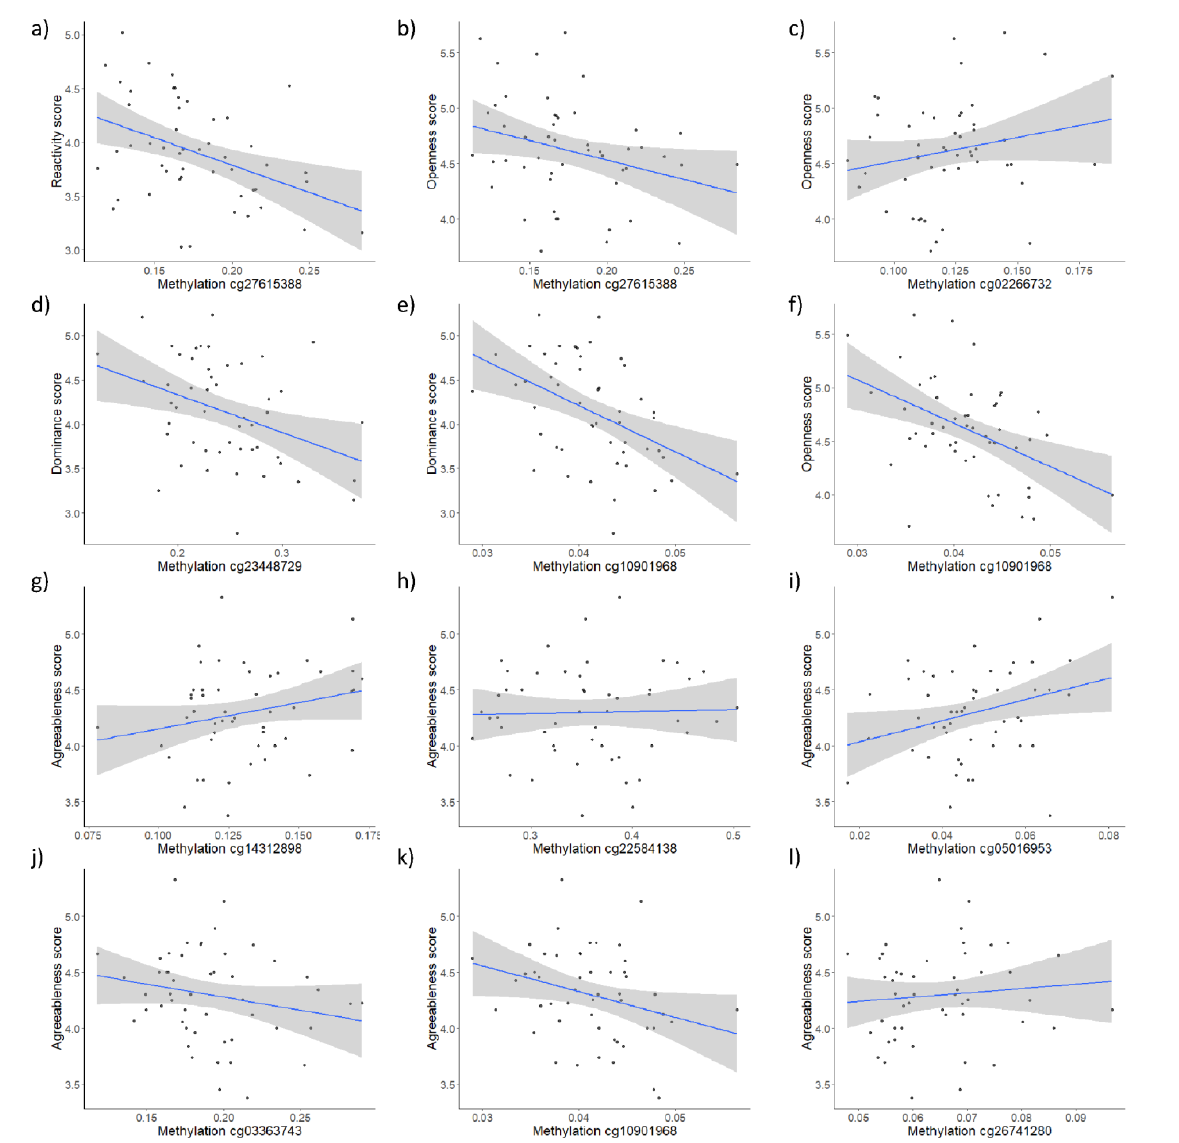
Figure 1. Significant associations between individual CpG methylation scores and personality do- mains for HTR1A ( a – d ) and SLC6A4 ( e – l